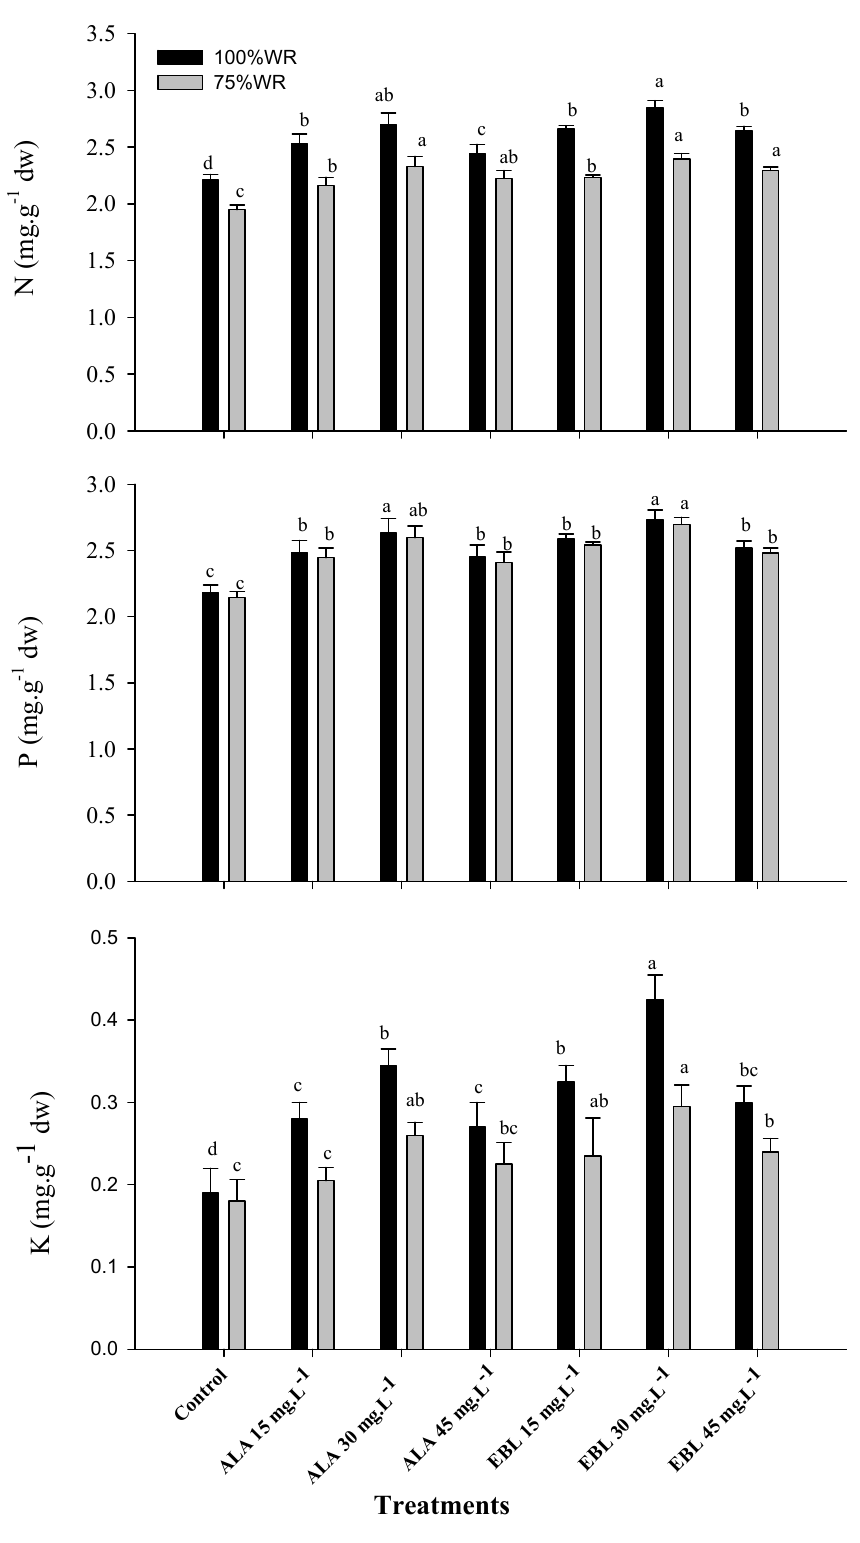
Figure 1. Effect of foliar spray with 5-aminolevulinic acid (ALA) or 24-Epibrassinolide (EBL) on the leaf nitrogen (N), phosphorus (P), and potassium (K) contents of drought-stressed “Williams” banana plants during the 2018/2019 and 2019/2020 seasons ( n = 5). The results are the averages of both seasons, and Duncan’s multiple range test (DMRT) was used for mean comparisons of treatments under each water requirement (WR) level ( p ≤ 0.05).